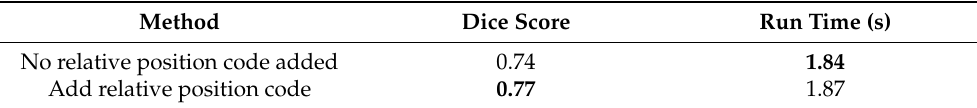
Table 2. Ablation performance of the MHA module for relative position encoding.